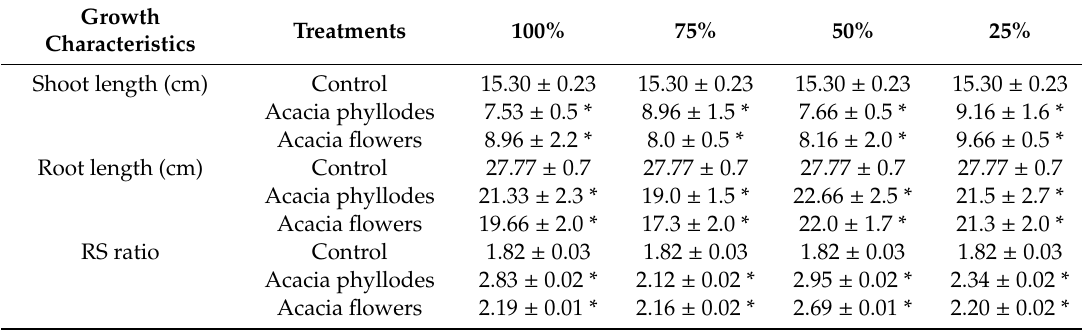
Table 3. E ff ect of aqueous extract of aerial foliage of Acacia melanoxylon R. Br. on shoot length (cm) and